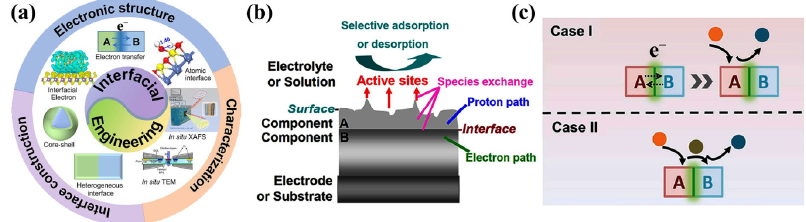
Figure 7. ( a ) Illustration of interfacial engineering of heterogeneous catalysts. Reproduced with permission from Ref. [85]. Copyright 2021, Elsevier B. V. ( b ) Illustration for an ideal simple triple-phase boundary structure where the electron path, proton path, and solution phases are presented together with active sites. Reproduced with permission from Ref. [84]. Copyright 2015, Elsevier B. V. ( c ) A catalyst composed of component A and component B with an interface between both of them. In case I, A provides the active sites for the catalytic reaction. B modifies the surface environment of A for optimal electrocatalysis. In case II, the adsorption and desorption processes occur on A and B separately. Reproduced with permission from Ref. [83]. Copyright 2018,